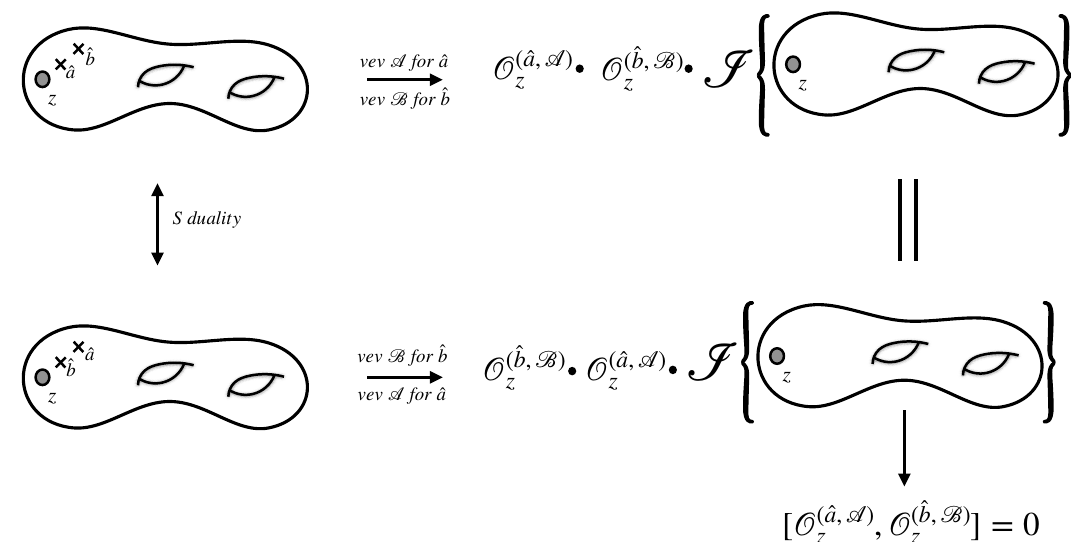
Figure 2: We start from a theory with a maximal puncture (labeled by z ) and two minimal punctures (labeled by ˆ a and ˆ b ). We close both minimal punctures by giving a space-time dependent vacuum expectation value to operators charged under the two puncture symmetries, resulting in a theory with surface defects. The choice of operators is schematically encoded in A and B . We can perform the computation of the index after giving the vevs in any duality frame and the result should not change. Here we present two frames which will result in the index being computed by acting on the index without the defect with two difference operators in different order. As the result does not depend on the frame the operators have to commute when acting on the index. Assuming that the index is a generic enough function this implies that the operators